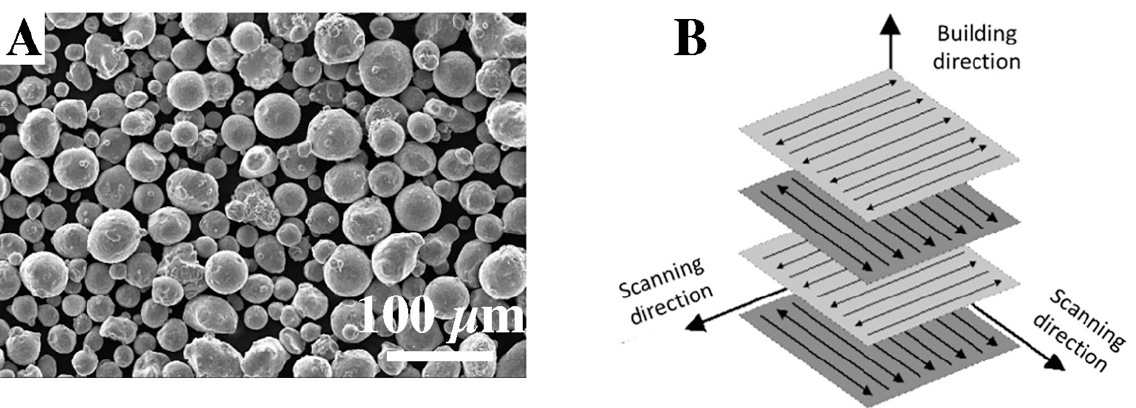
Figure 1. AlSi10Mg powder ( A ), scanning strategy of DMLS process ( B ). Table 1. DMLS process parameters.